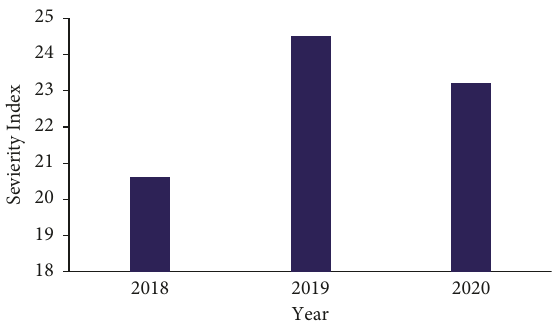
Figure 3: Severity index and the corresponding